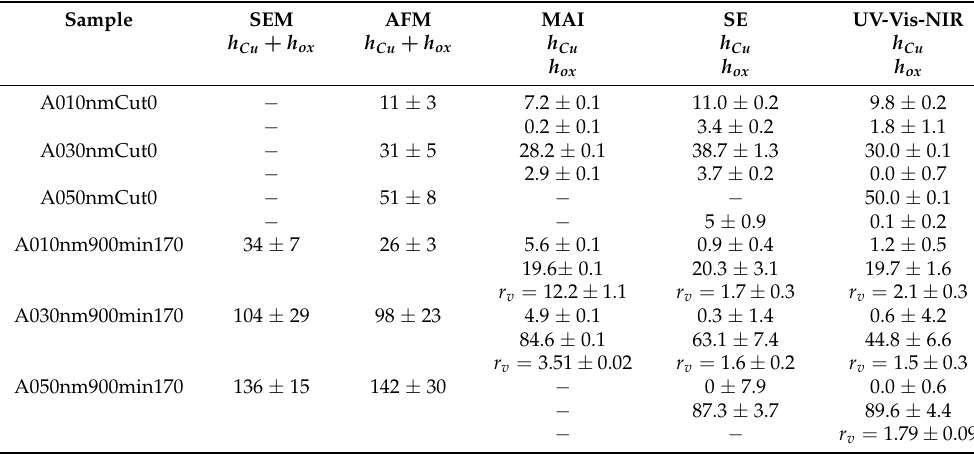
Table A2. Measured thicknesses (nm) of raw and fully oxidized